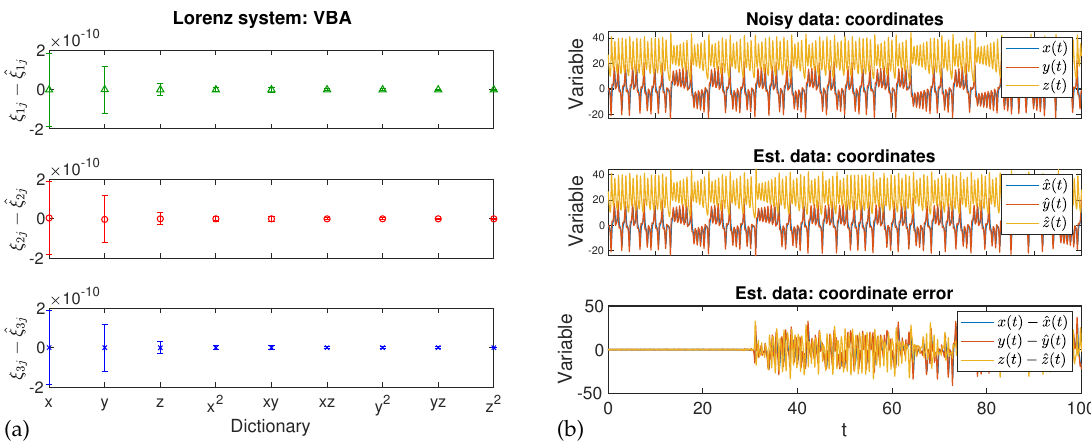
Figure 4. Output of VBA regularization: ( a ) differences in predicted parameters ξ ij − ˆ ξ ij (the error bars indicate inferred standard deviations), and ( b ) comparison of original and predicted time series X